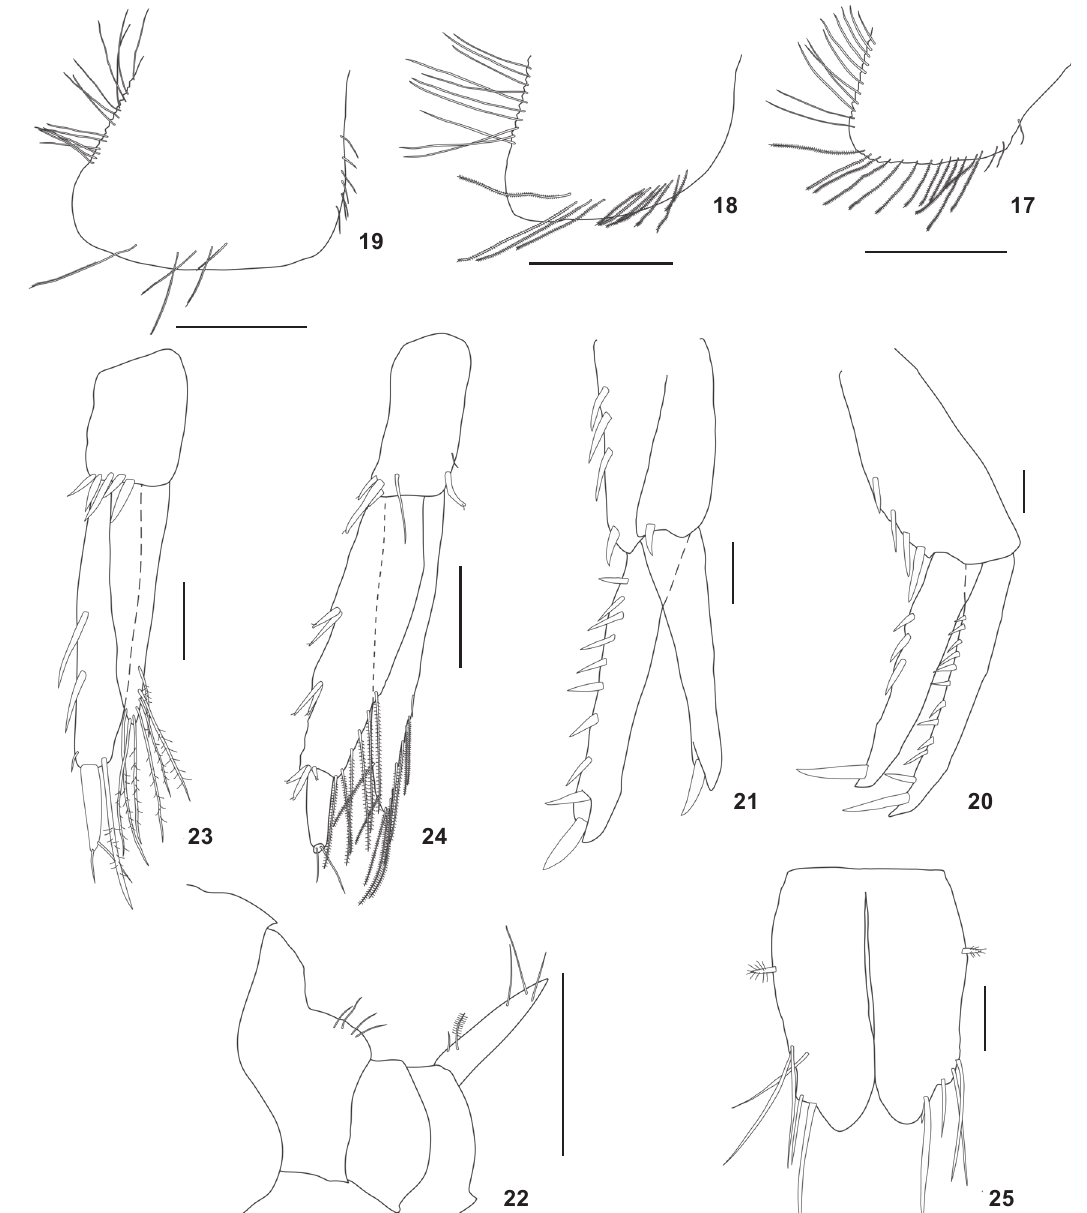
Figures 17-25. Metharpinia taylorae sp. nov. , holotype, female: (17) epimeral plate 1; (18) epimeral plate 2; (19) epimeral plate 3; (20) uropod 1; (21) uropod 2; (22) urosomite 3; (23) uropod 3; (25) telson; paratype, male: (24) uropod 3. Scale bars: 0.2 for male and female uropod 3; 0.5 mm for the